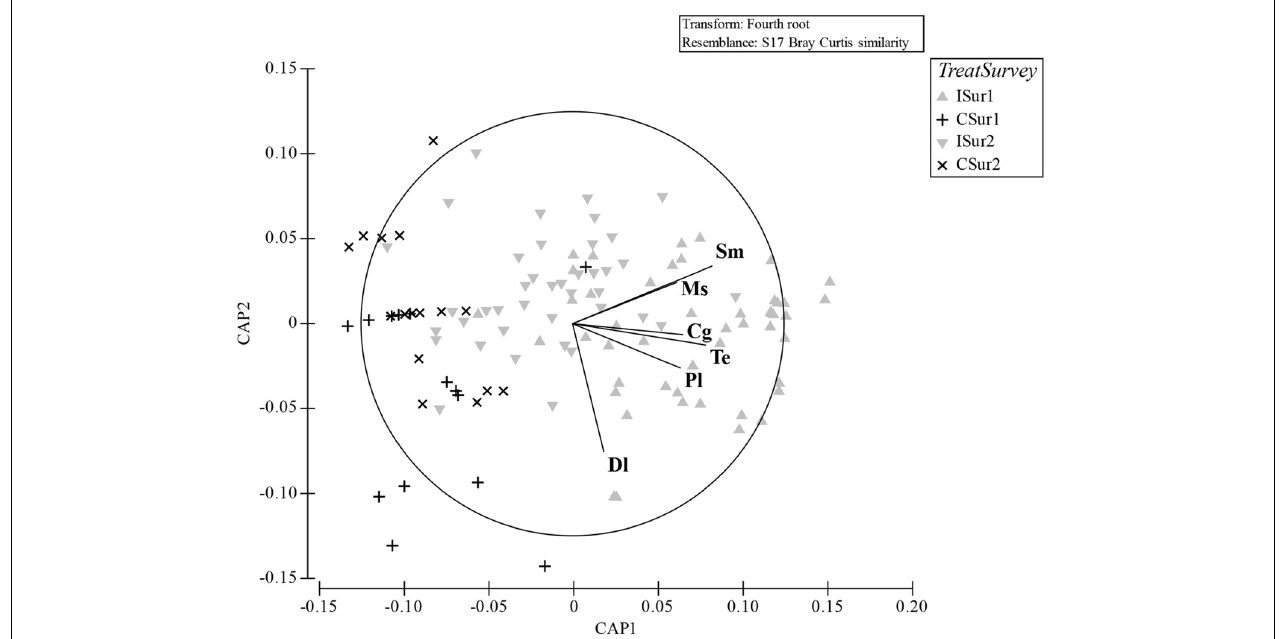
FIGURE 5 | CAP analysis ordination plot based on the Bray–Curtis similarity matrix of the molluscs assemblages sampled during the two surveys with superimposed the species that most differentiated the replicates (Pearson’s correlation index; cut-off 0.5). I, impact; C, control; Sur1, first survey; Sur2, second survey. Dl, Dosinia lupinus ; Sm, Solen marginatus ; Ms, Mactra stultorum ; Cg, Chamelea gallina ; Pl, Pharus legumen ; Te, Tellina exigua .